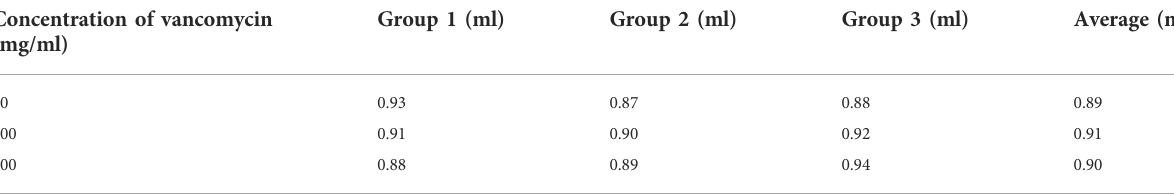
TABLE 1 The largest loading volume of vancomycin onto 1 G of Bicera ™ .